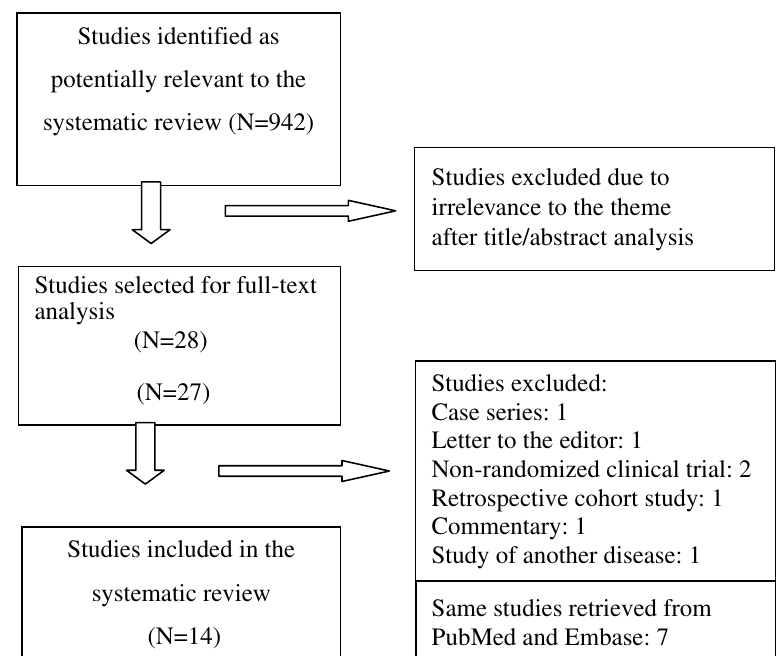
Figure 1 - Search strategies used to identify